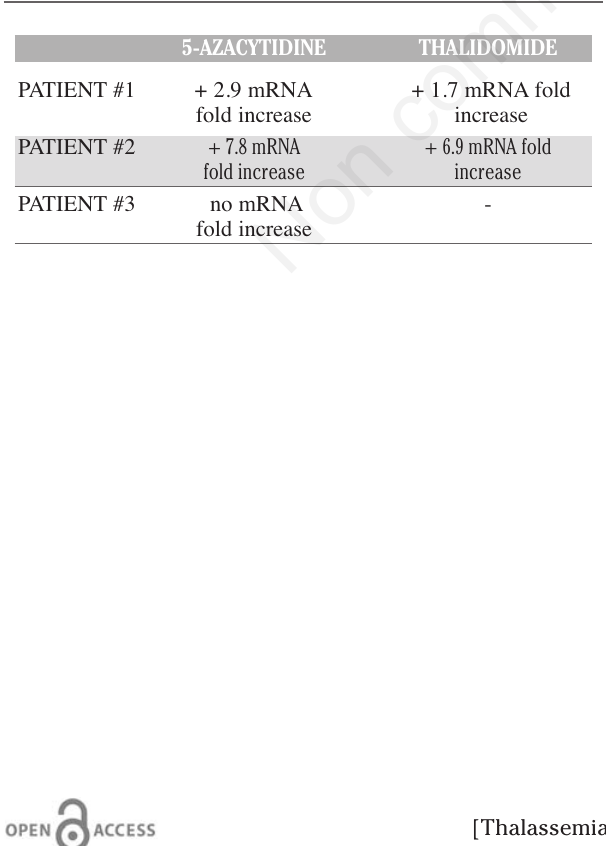
Table 1. In vitro response of three patients to 5-azacytidine and